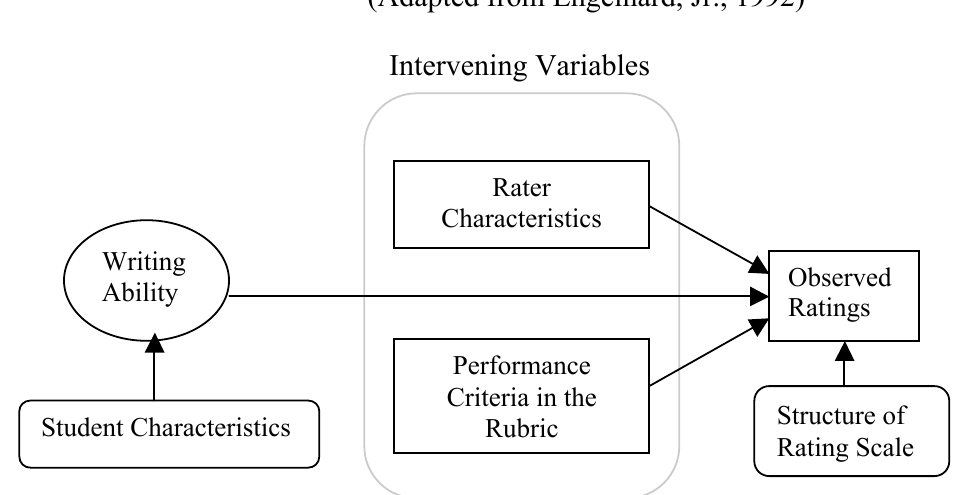
Measurement Model Underlying the CEP Writing Test (Adapted from Engelhard, Jr., 1992) Intervening Variables